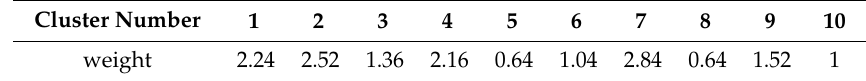
Table 2. The weight value of each cluster.